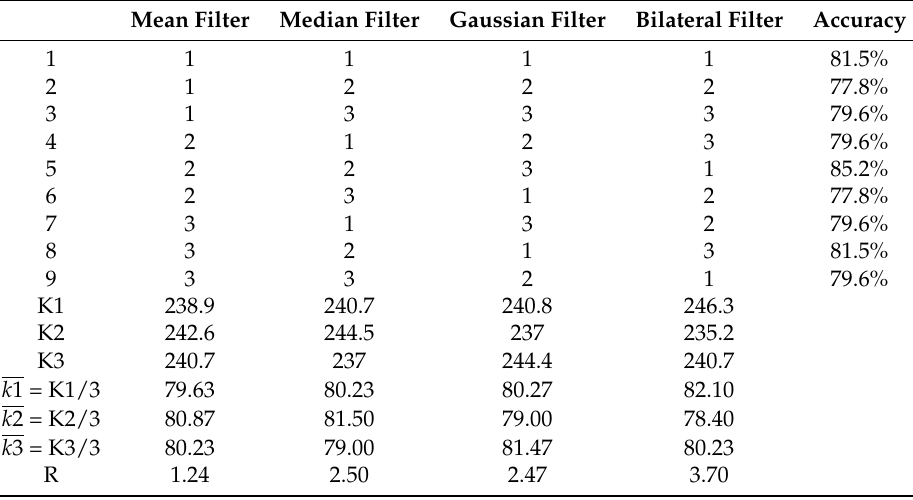
Table 3. The orthogonal experiment of filter